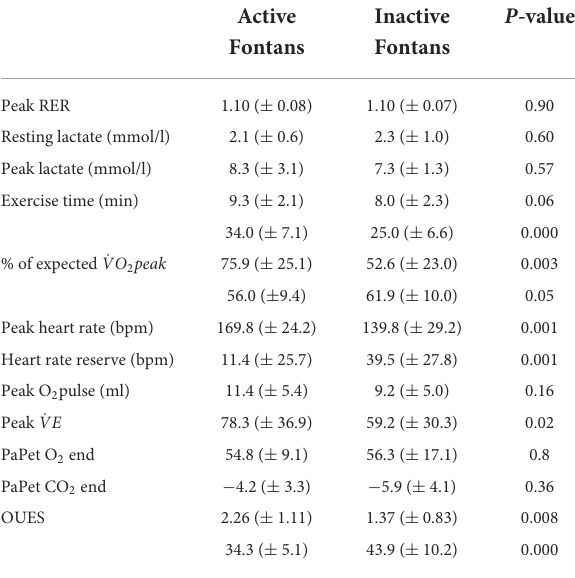
TABLE 5 Mean values ( ± standard deviation) and the p -value for the t -test from the cardiopulmonary exercise test of active vs. inactive